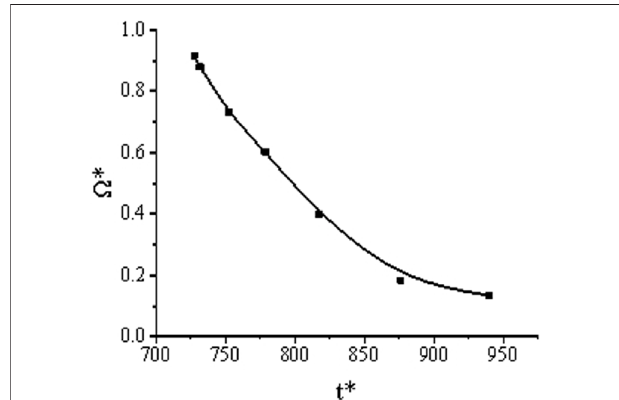
FIGURE 13 | Changes of helicity coef fi cient under different formation